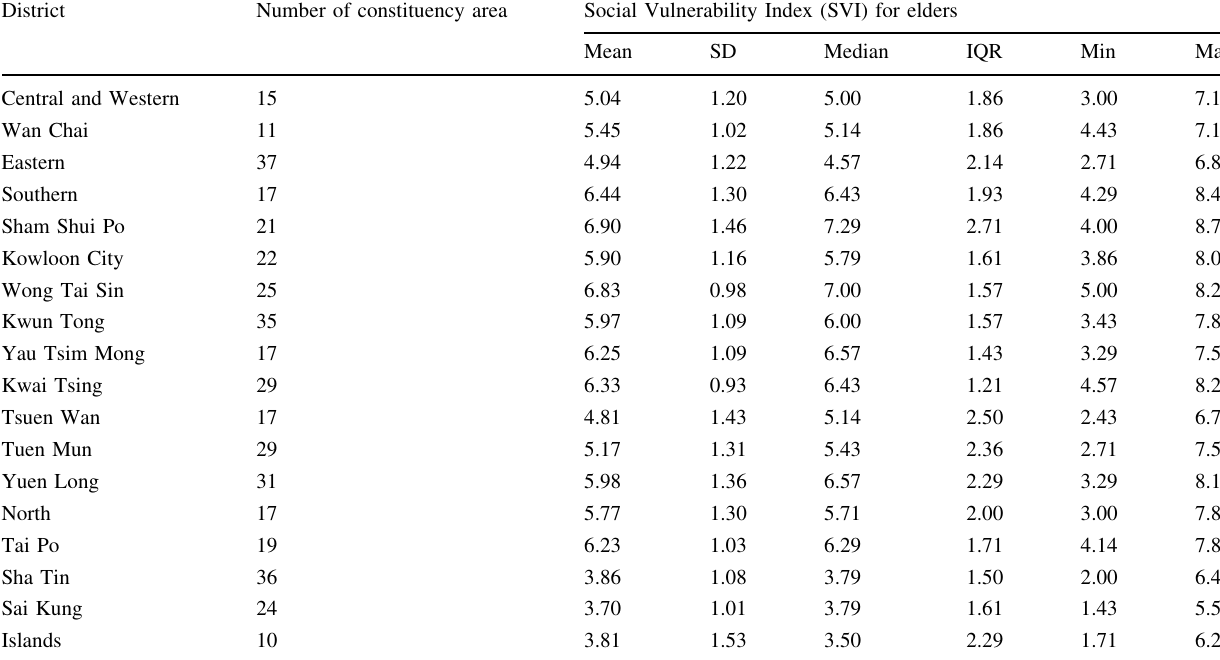
Table 2 Summary statistics of the SVI for elders within each district in Hong Kong, 2011 District Number of constituency area Social Vulnerability Index (SVI) for